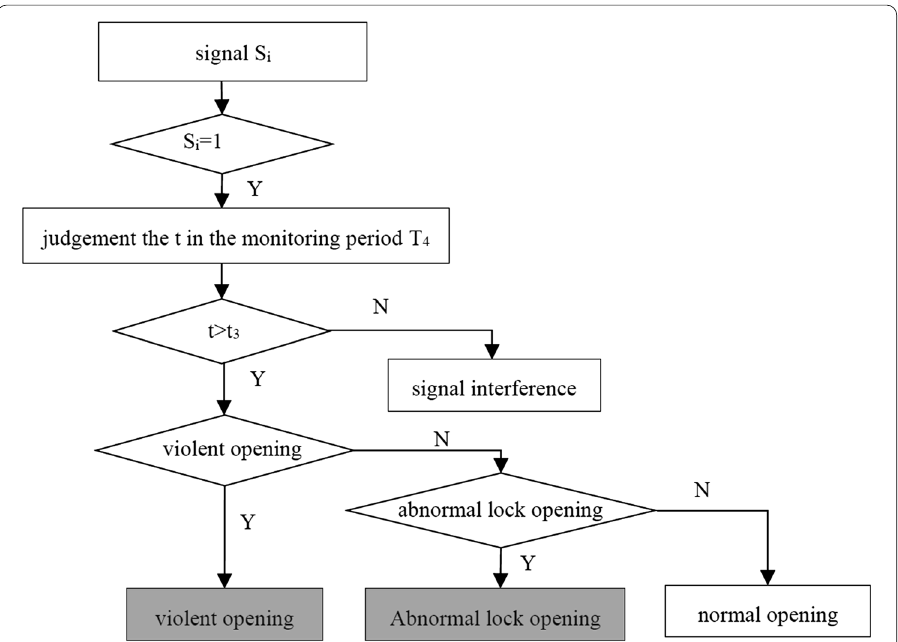
Fig. 7 The judgment method for abnormal opening event of the inner manhole